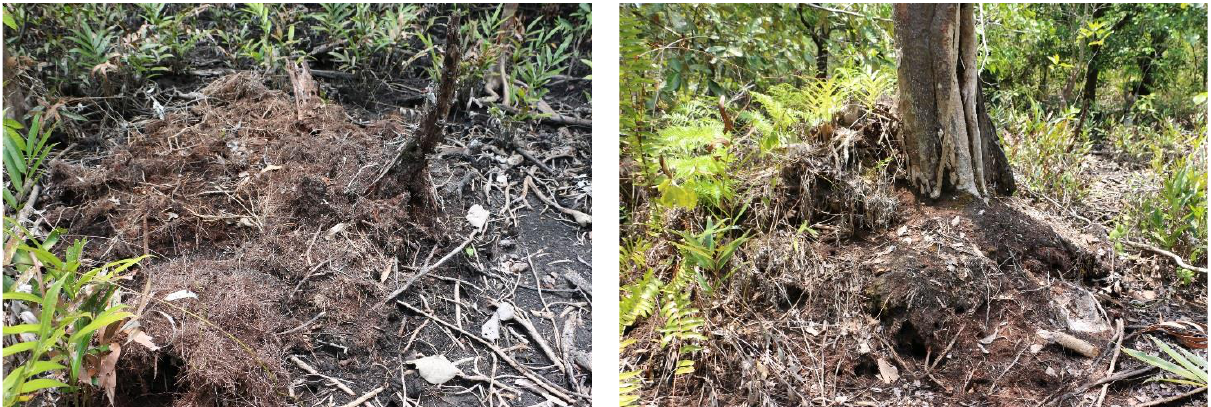
Figure 3. Example observations of peat piling up at the bases of tree trunks, showing coarse, loose organic matter (left) and more-consolidated organic matter